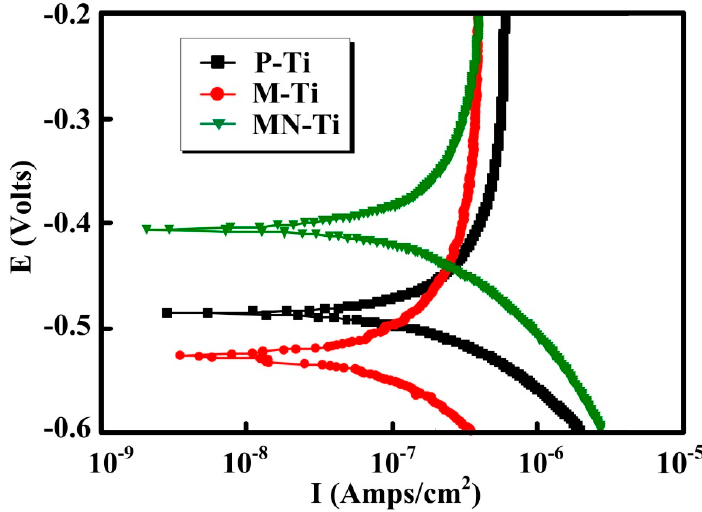
Figure 7. Polarization curves of P-Ti, M-Ti, and MN-Ti in NaCl solution.